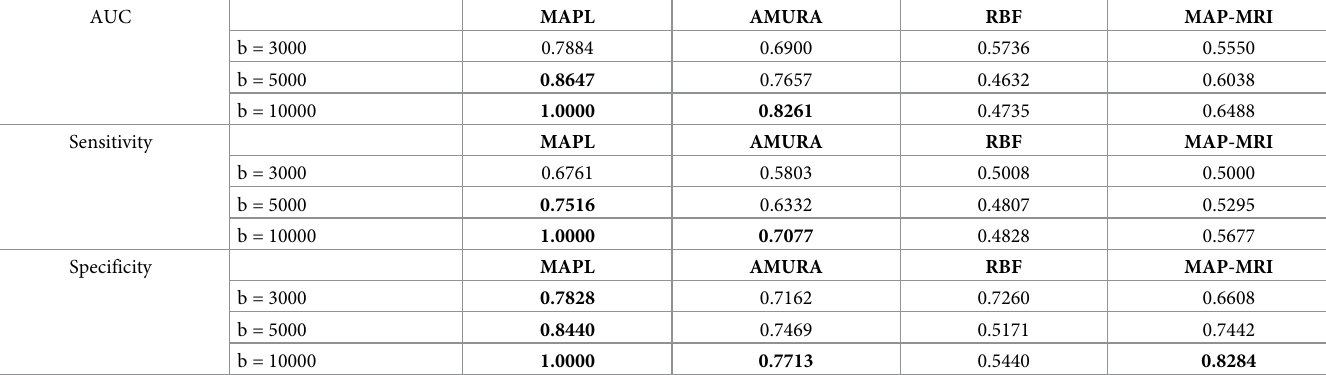
Table 5. ROC FoMs for RTPP (the closer to 1, the better). MAPL with 4 shells at a maximum b = 10,000s/mm 2 is the bronze standard. AUC